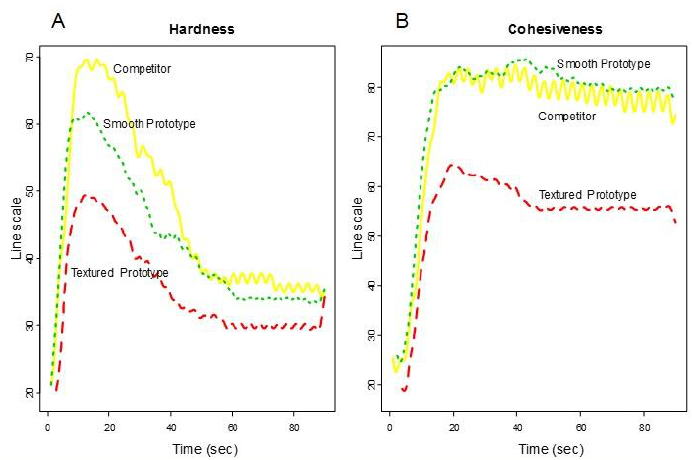
Figure 2. Consumer chew-down Overall Liking of Texture.